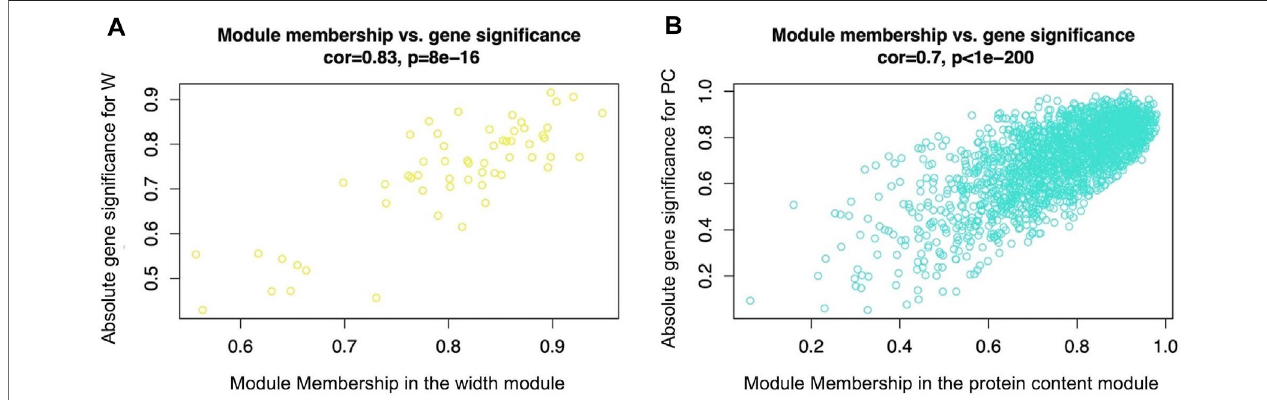
FIGURE 1 | Scatterplot of absolute gene signi fi cance (GS, y -axis) plotted against the gene module membership (MM, x -axis) of the modules selected for further analysis:thewidthmoduleFigure1 (A) ,whichwasthemodulemostsigni fi cantlyrelatedtobreastmusclewidth(Wtrait)(evaluatedin52-day-oldbroilers ’ Pectoralismajor muscles), and the protein content module (B) , which was the most signi fi cant module related to breasts protein contents (PC trait) (evaluated in 52-day-old broilers ’ Pectoralis major muscles).